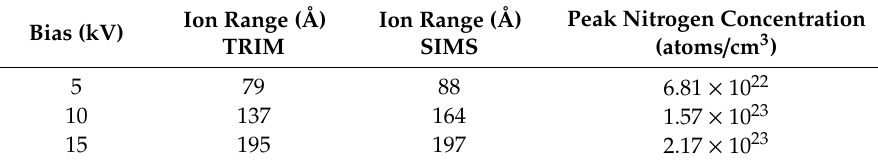
Figure 3. S econdary ion mass spectrometry (SIMS) depth profiles of nitrogen contents in the implanted samples at the different bias voltages. Table 3. Implanted ion range of TRIM simulations and SIMS analysis